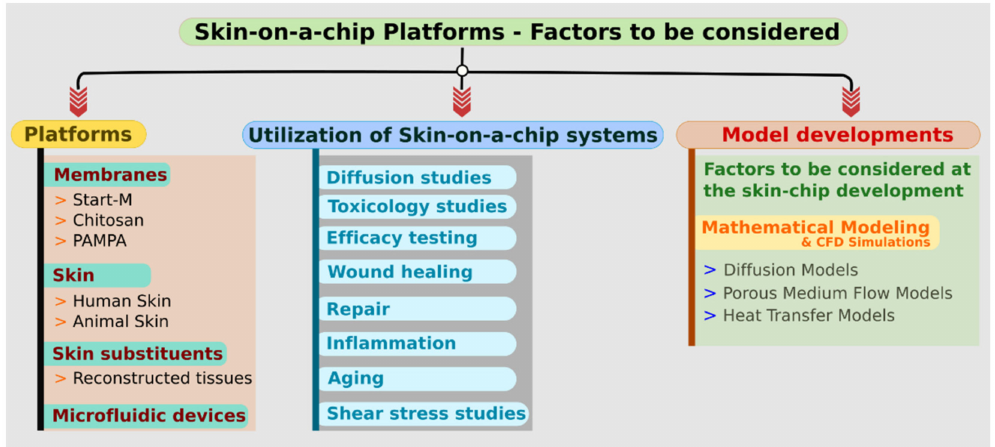
Figure 1. Chart showing the different factors to be considered in the case of skin-on-a-chip platforms.